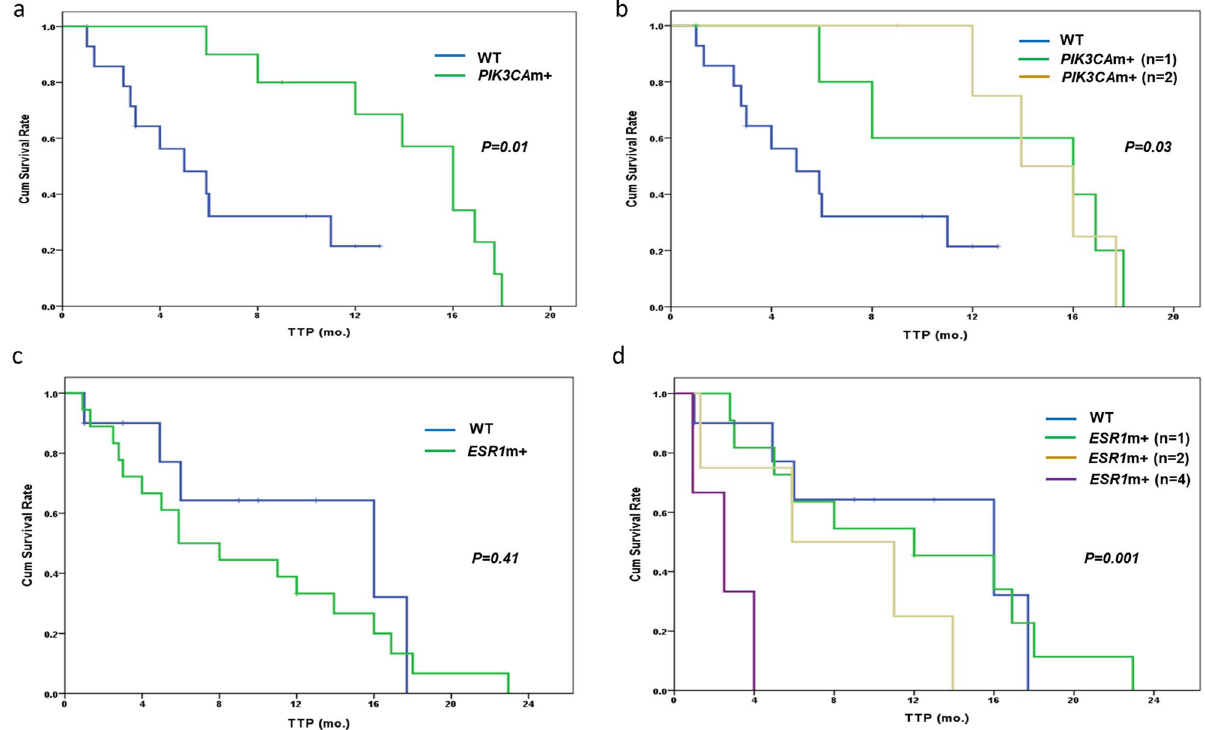
Figure 3. Time to progression (TTP) of EverX (Exemestane+ Everolimus) treatment after enrollment according to the presence of PIK3CA and ESR1 mutations. ( a ) TTP according to the presence of PIK3CA mutations. ( b ) TTP according to the number of PIK3CA mutations. ( c ) TTP according to the presence of ESR1 mutations. ( d ) TTP according to the number of ESR1 mutations.